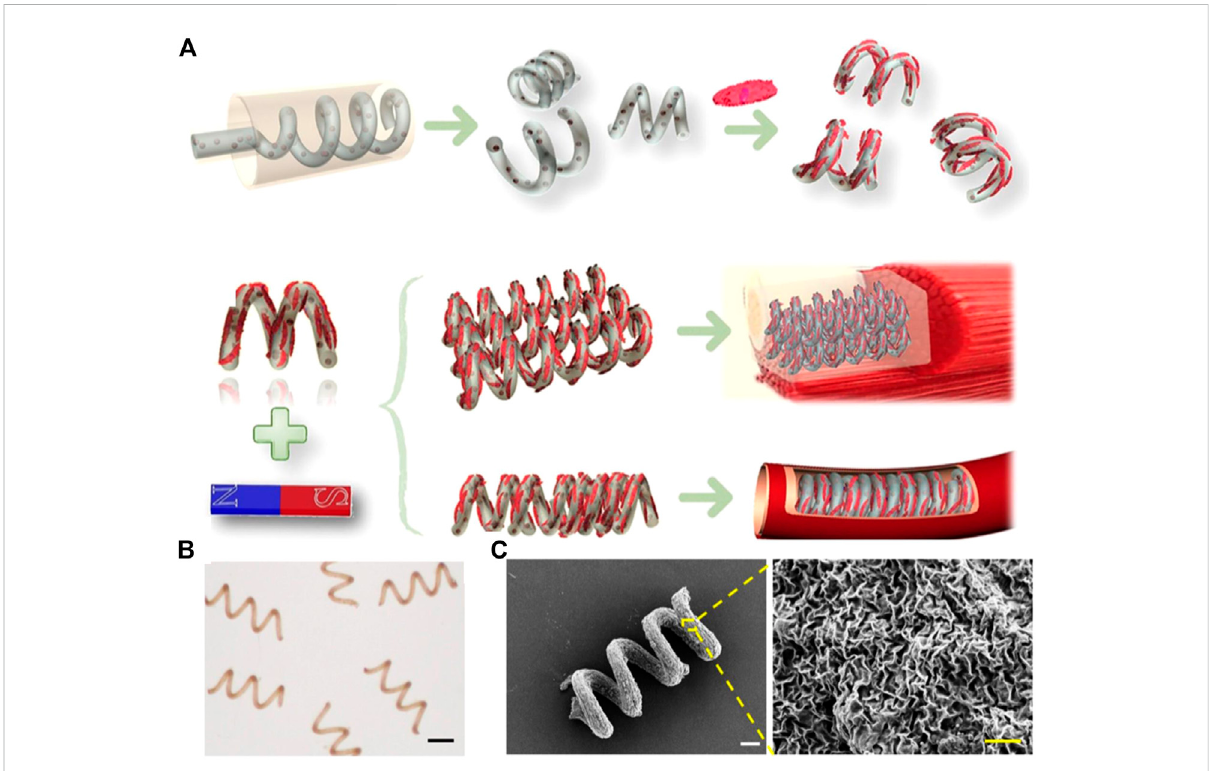
FIGURE 4 Magnetic helical micromotors prepared with micro fl uidic techniques. (A) Schematic illustrations of the fabrication of the helical micromotors and their potential applications. (B) Photograph of the helical micromotors. Scale bar = 300 µm. (C) SEM images of the helical micromotor.